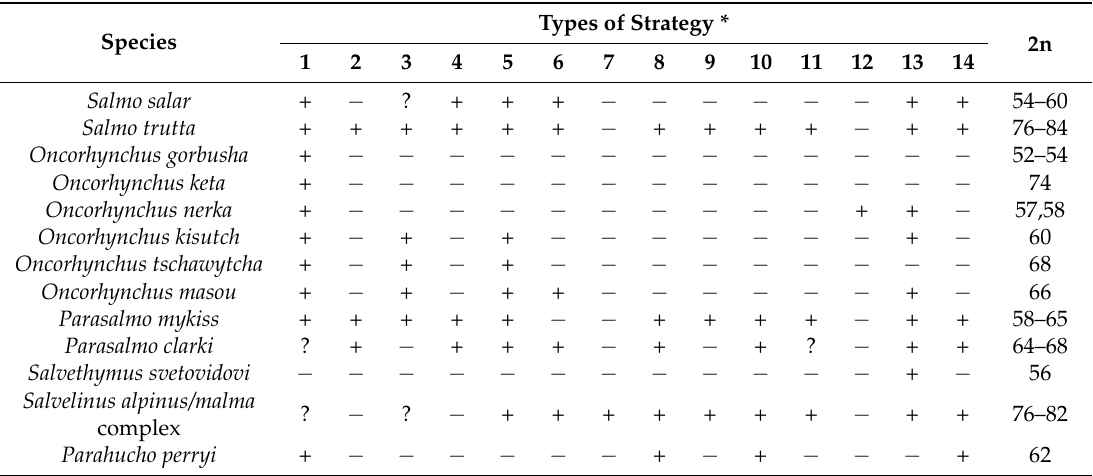
Table 1. Types of anadromous and resident life strategy in Salmoninae ([25], with addition) and their chromosome number (2n)